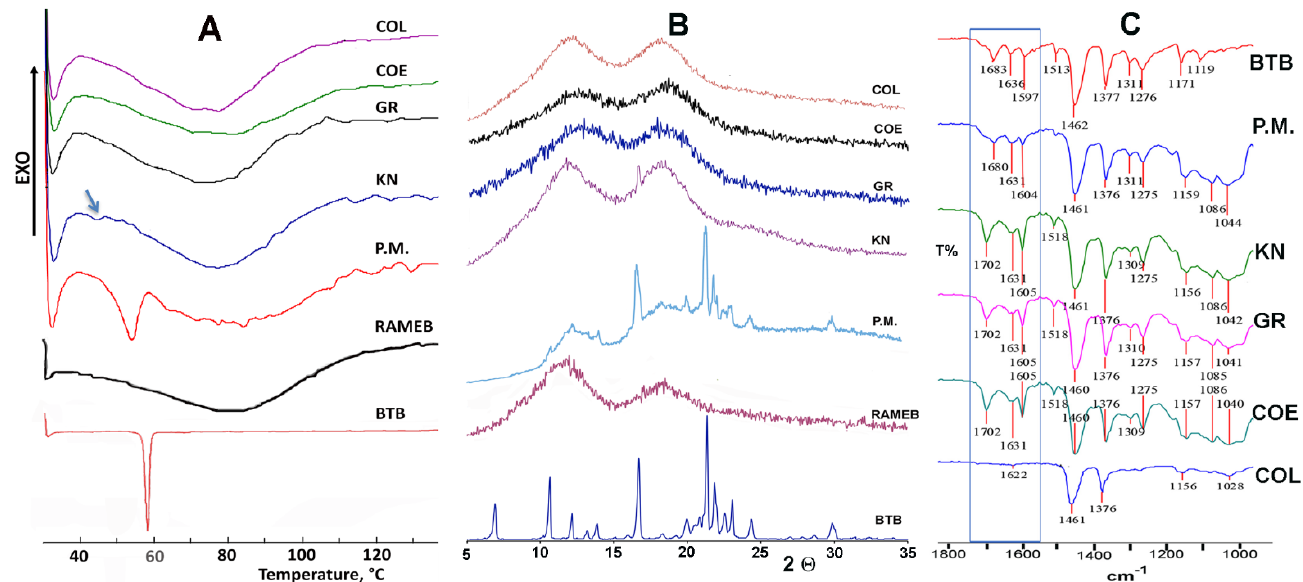
Figure 2. ( A ) DSC curves, ( B ) Xray powder diffraction spectra, and ( C ) FT-IR spectra of pure butamben (BTB) and RAMEB, and of their equimolar solid systems obtained by physical mixing (PM), kneading (KN), co-grinding (GR), coevaporation (COE) and colyophilization (COL).